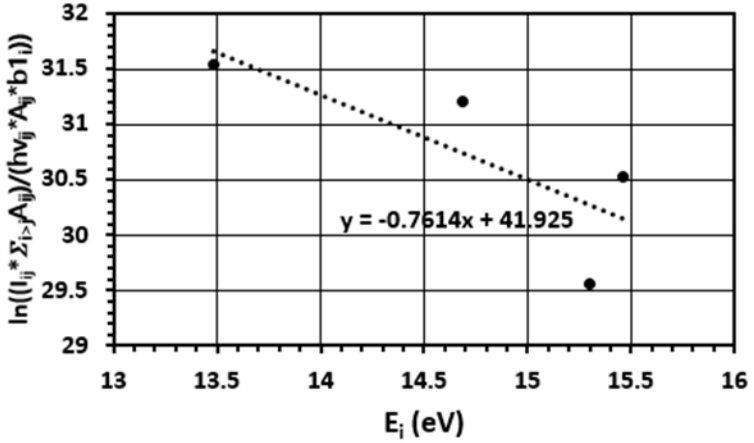
Figure 1. Modified Boltzmann method used to derive electron